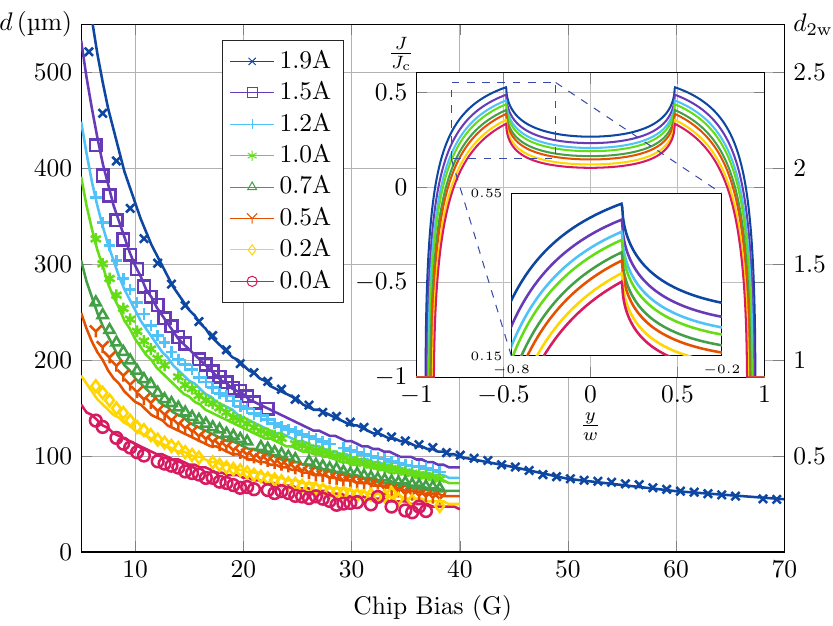
Figure 5: Probing the distance of the atomcloud to the chip surface at different trans- port currents for the same previously reached current maxima: The discrete markers are experimentally measured distances versus bias field for various currents down to zero transport current. The presence of the zero-current-trap indicates the pres- ence of remanent magnetization in the superconducting film. The solid curves are fits using the current history assuming a previously reached I distribution used for the fits is shown in the inset for the respective transport current. See text for more details.